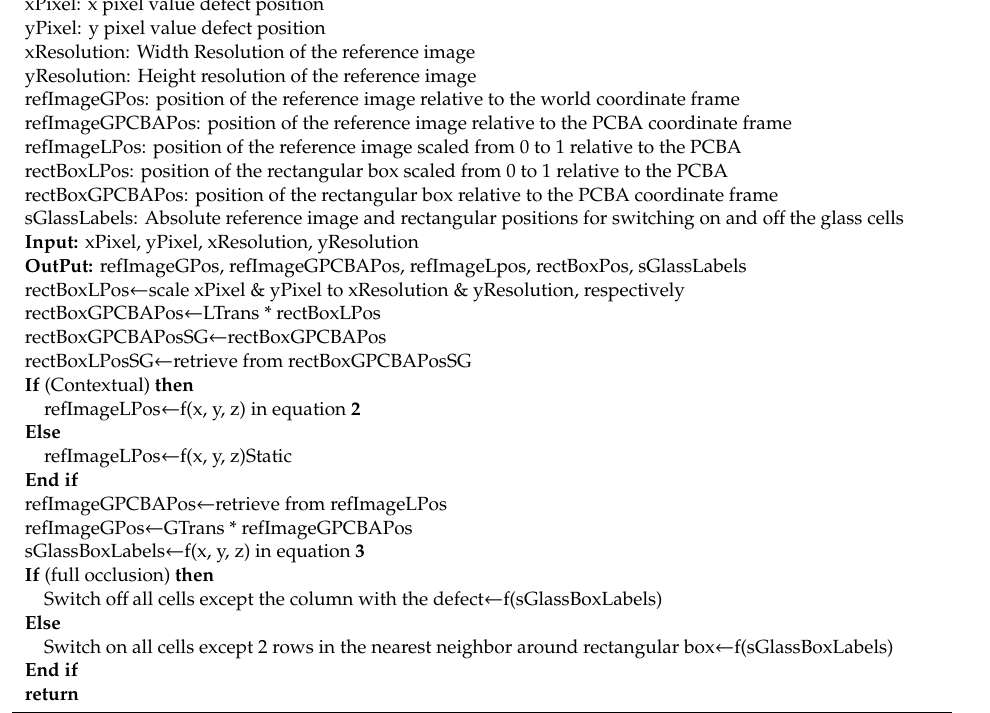
Table 2. Reference Image Contextualization